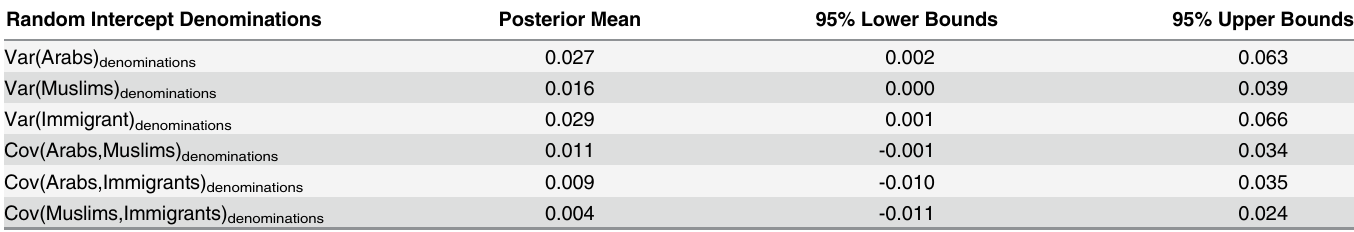
Table 5. Co/Variance Solutions